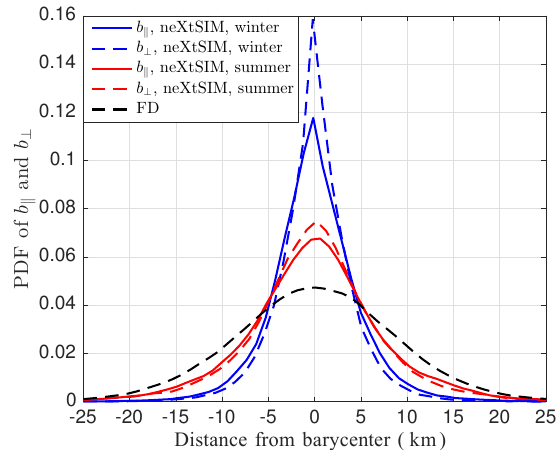
Figure 10. Probability density function (PDF) of b (cid:107) (t) (solid lines) and b ⊥ (t) (dotted lines) at t = 10 days for neXtSIM in the winter (blue) and summer (red). The PDFs from FD are similar for summer and winter, and for b (cid:107) (t) and b ⊥ (t) , and are therefore shown as a single black dashed line.